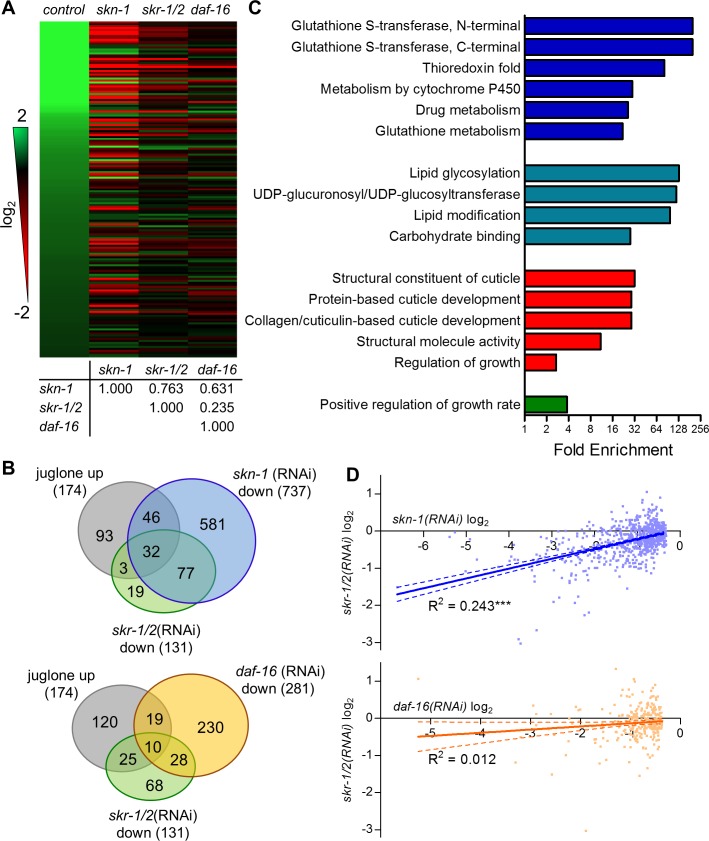
Whole transcriptome profiling reveals correlation between loss of skn-1 and skr-1/2.(A) Heat map of log2 fold-change of 174 genes found to be significantly up-regulated by juglone (38 μM for 3 h) with their corresponding fold-changes in worms fed with skn-1, skr-1/2, or daf-16 dsRNA compared to control dsRNA. Fold-change analysis for RNA-seq data were carried out using the CuffDiff application in Galaxy with q-value <0.05 determined by a false discovery rate of <5%. n = 3 replicates of 1,000–2,000 worms. Coefficients of correlation are listed below the map and 95% confidence intervals are as follows: skn-1 and skr-1/2 (0.693–0.818), skn-1 and daf-16 (0.533–0.712), and skr-1/2 and daf-16 (0.090–0.370). (B) Venn diagrams showing numbers of genes overlapping. (C) DAVID functional enrichment analysis of skr-1/2(RNAi) down-regulated genes. (D) Linear regression analysis of all genes down-regulated by either skn-1 or daf-16(RNAi) plotted against their fold change with skr-1/2(RNAi). ***P<0.001 as determined by linear regression F-test.